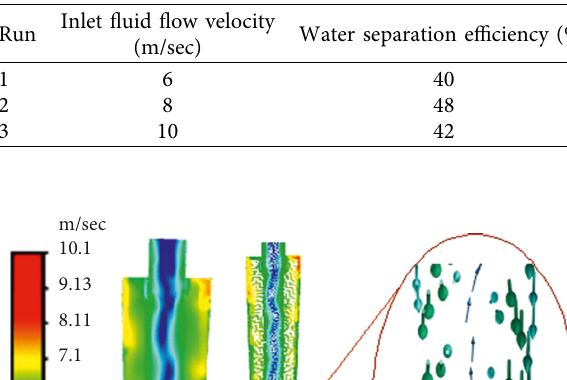
Figure 9: Effect of droplet size on the separation efficiency. Table 4: Efficiency of water separation in the